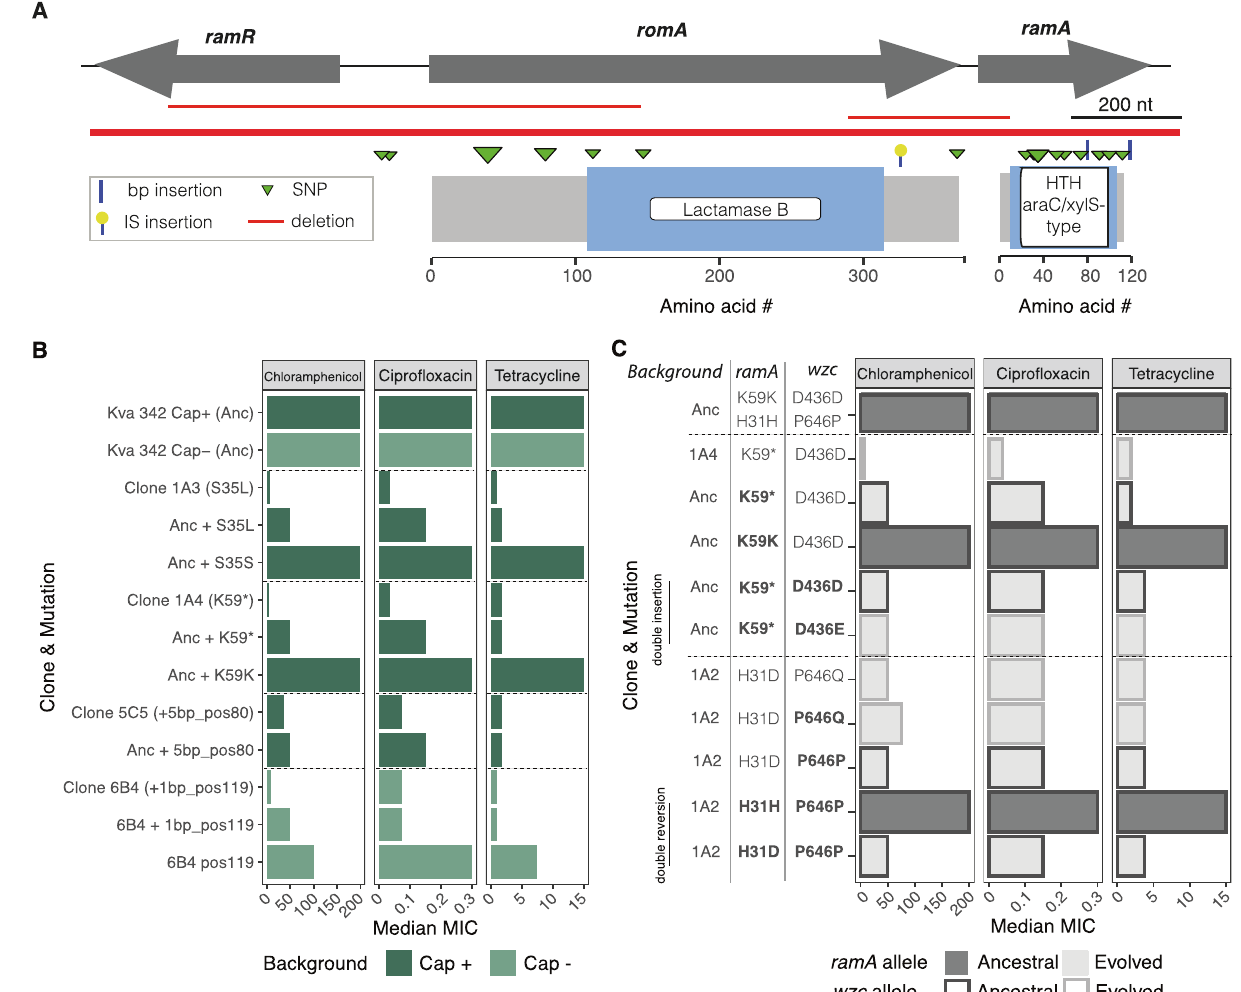
Fig. 6 | Mutations in ramA reduce MIC ofseveral antibiotics.A Geneticdiagram indicatingthelocationofmutationsinthe ramA/romA/ramR locus.Thelowerpanel represents the length and the predicted functional domains of each protein. The position of the triangles (and lines) indicates mutations (and deletions) and their size indicates the number of times the same change occurred independently. B Median MIC of several ramA mutants and their respective wild-type controls resultingfromthesamedoublerecombinationevent. ‘ pos ’ referstothenucleotide